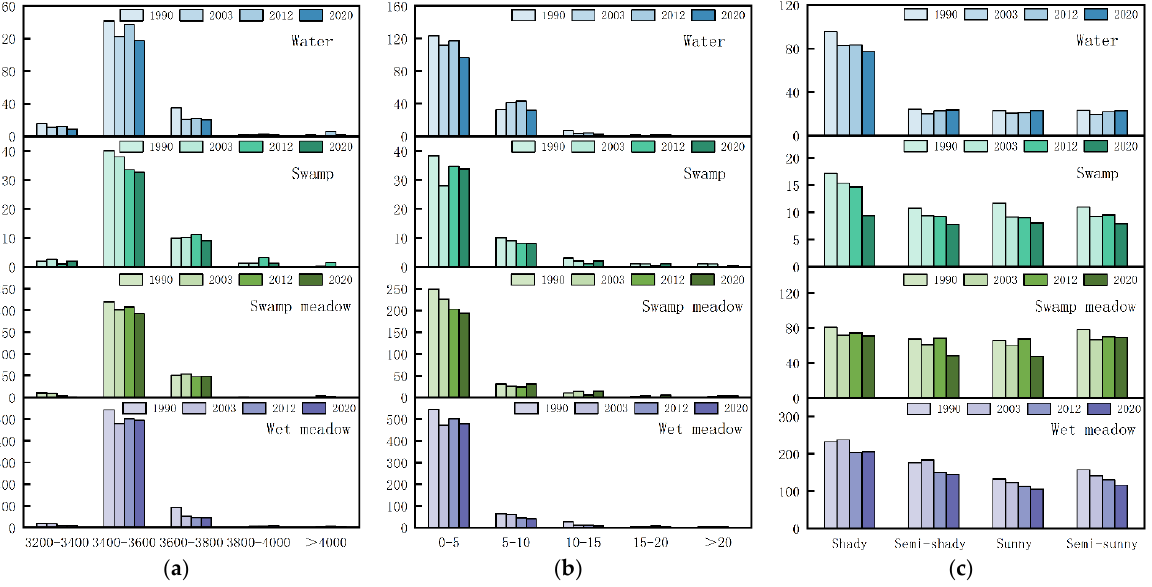
Figure 11. Topographic features of the wetland distribution and changes. ( a ) Elevation, ( b ) Slope, ( c ) Aspect.